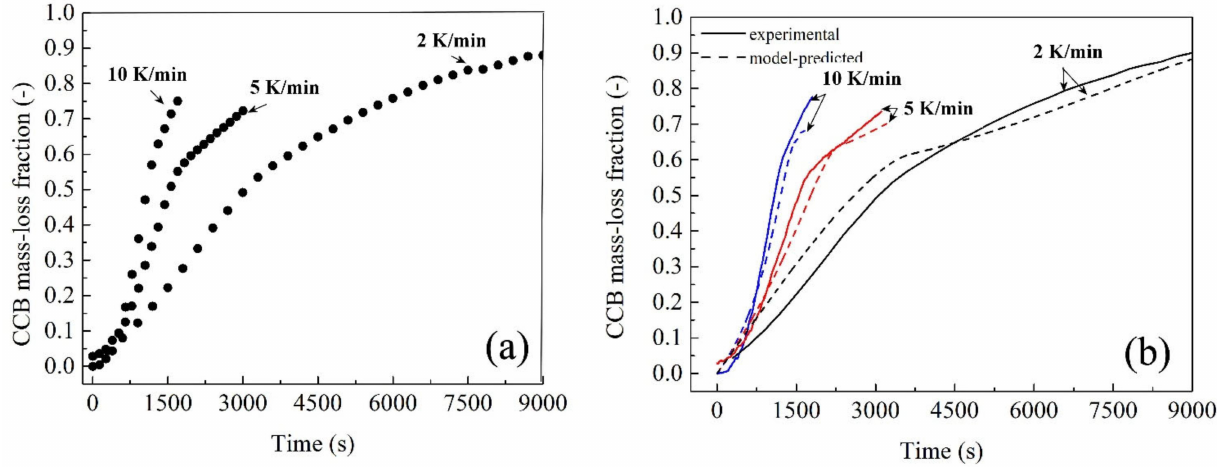
Figure 3. Determination of CCB model parameter of a gs : ( a ) experimental data points for fitting, and ( b ) comparison between model prediction curve and experimental curve under different heating rates.